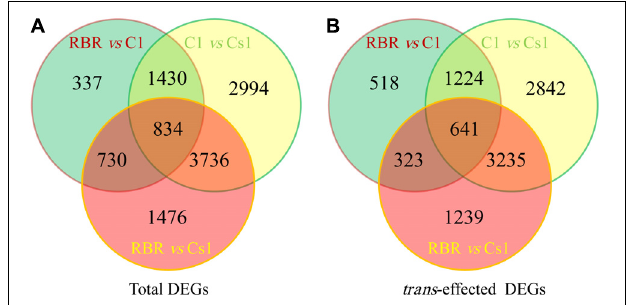
FIGURE 3 | Total and trans -effected differentially expressed genes (DEGs) from three comparisons are shown in Venn diagram (http://bioinformatics.psb.ugent.be/webtools/Venn/). (A) Venn analysis for total DEGs. (B) Venn analysis for trans -effected DEGs.